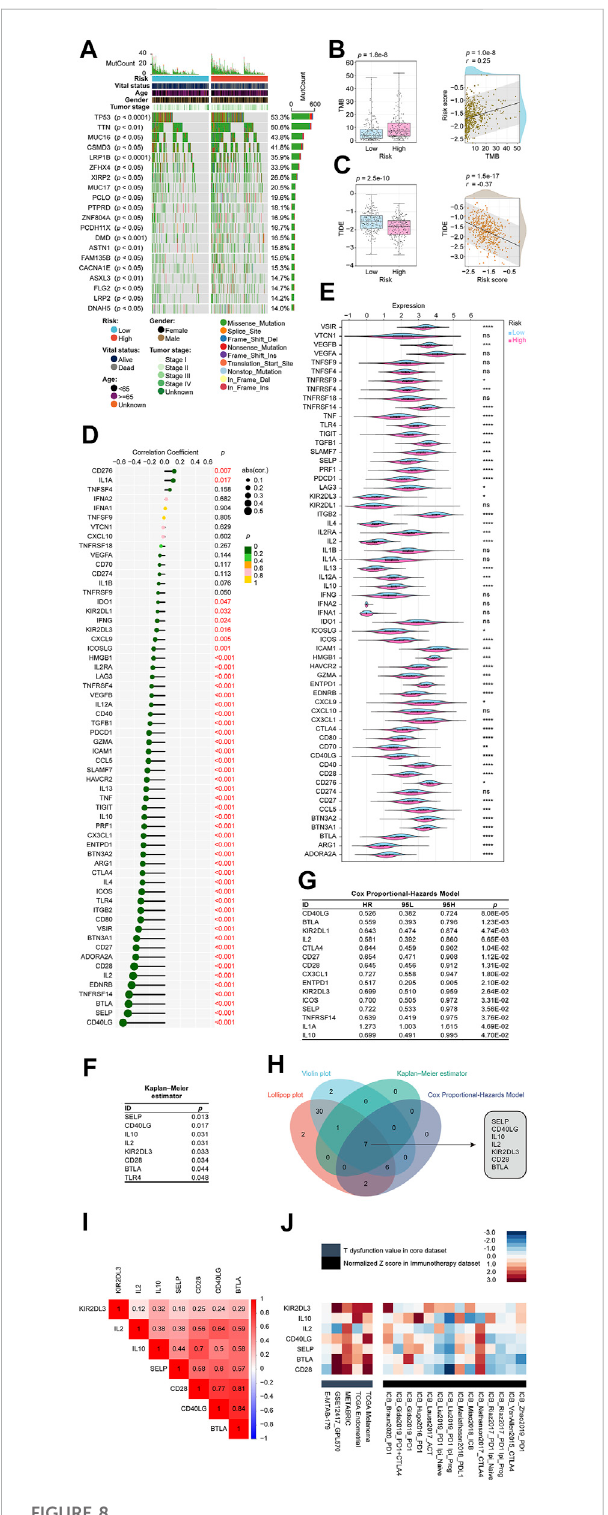
FIGURE 8 Determination of the relationship between the CRLncSig and immunotherapy. (A) The waterfall plot shows the top 20 genes mutated in the LUAD, and their difference in the high and low risk groups. (B) The TMB difference in the high and low-risk patients tested by the Wilcoxon rank-sum showing in form of boxplot. The correlation between TMB and the signature tested by the Pearson coef fi cient showing in form of scatterplot. (C) The TIDE difference in the high and low-risk patients tested by the Wilcoxon rank-sum